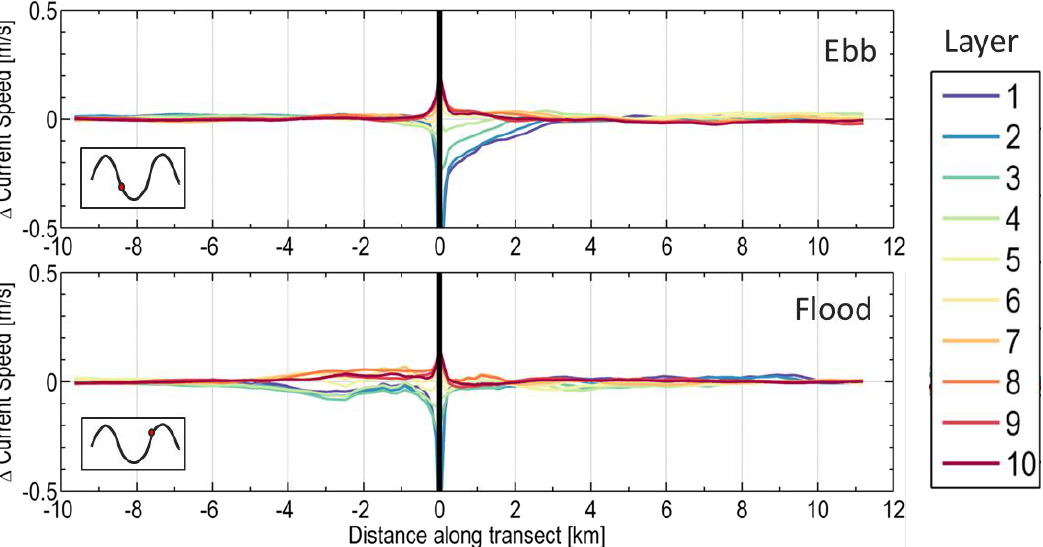
Figure 21. Difference in current magnitudes due to HCB relative to test 1, plotted along Transect-b for all model layers. The ( top ) panel presents peak ebb and the ( bottom ) panel presents peak flood results averaged over the calibration period of 25 April–11 June 2017. (The distance between −10 km and 0 km represents the region south of the bridge, while that between 0 km and 10 km represents the region north of the bridge).